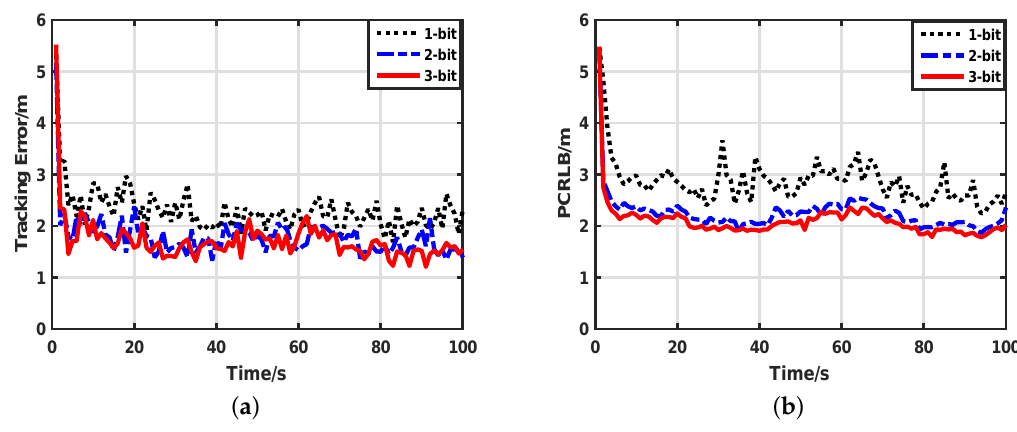
Figure 6. Target tracking performance of optimal quantization-based tracking scheme with different data lengths. ( a ) Target tracking error of optimal quantization-based tracking scheme; ( b ) posterior Cramer–Rao lower bound (PCRLB) of optimal quantization-based tracking scheme.